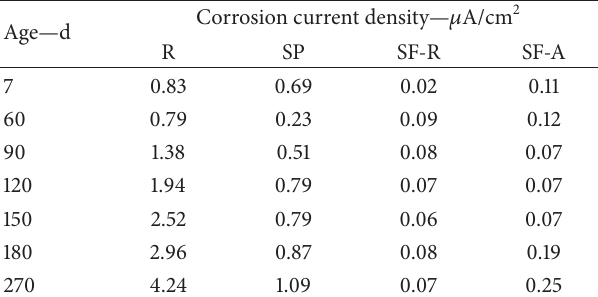
Table 5: Corrosion current density.